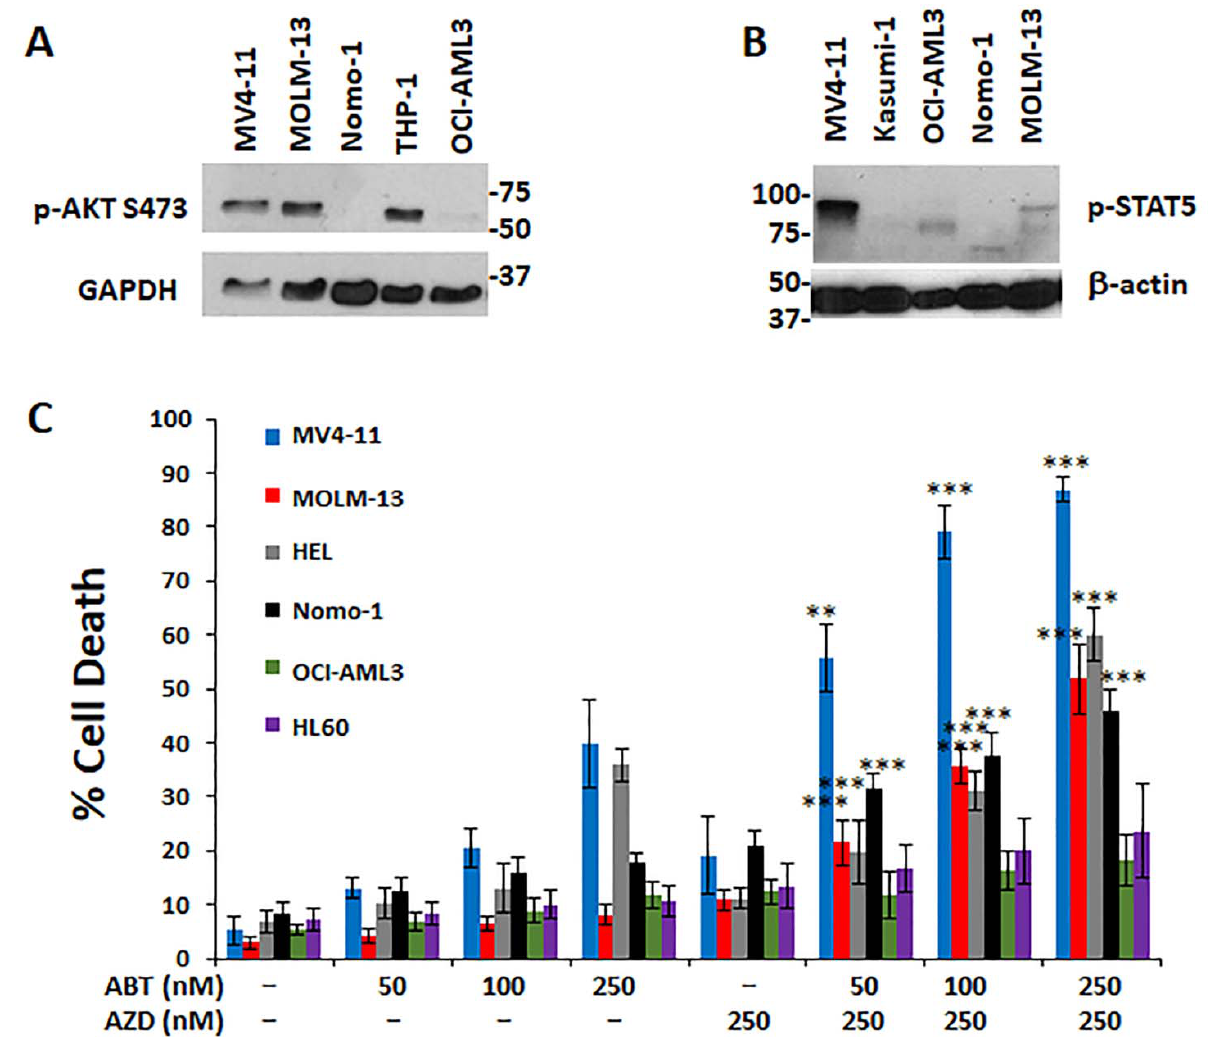
Figure 2. STAT5 and Akt activation are associated with BH3 mimetic resistance and downstream survival signals can be pharmacologically targeted to achieve synergistic response in Flt3-ITD + cells. ( A ) pAKT expression levels was measured by Western blot analysis in several cell lines, including mainly the MV4-11 and MOLM-13 lines. ( B ) pSTAT5 expression was analyzed in MV4-11 cells and directly compared with MOLM-13 cells. ( C ) Dual drug treatments for 48 h using ABT-263 + AZD 8055 was performed to test whether they would induce greater cytotoxicity in Flt3-ITD + cell lines (MV4-11 and MOLM-13). In comparison, a variety of other Flt3-ITD wild-type cell lines were also tested. ( n = 6, p values were calculated relative to the AZD 250 (nM) group). ** p < 0.01; *** p < 0.001.